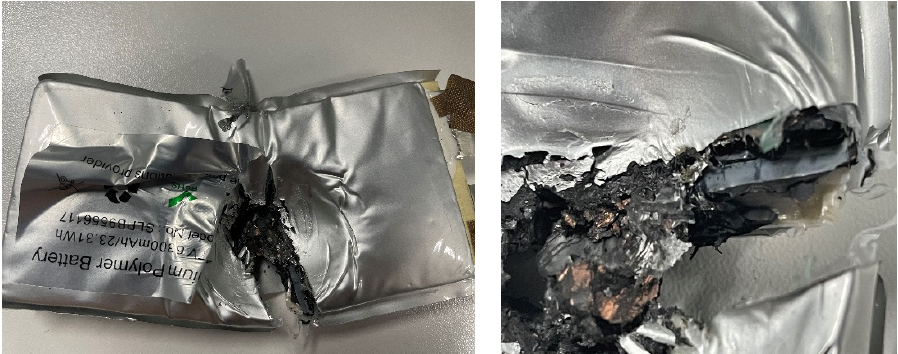
Figure 7. Post-experimental battery.